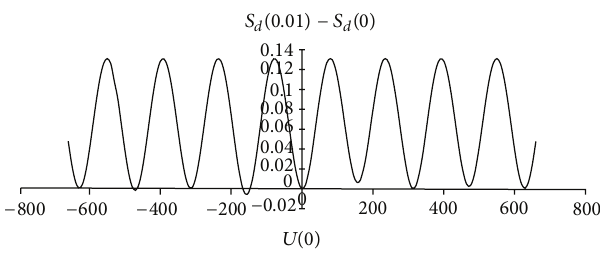
Figure 5: Change of the entropy with respect to 𝑆 𝑑 (0) at 𝑇 = 0.01 under different 𝑈(0) for system (69) with 𝐶(0) = [√3/2, 𝜄/2]